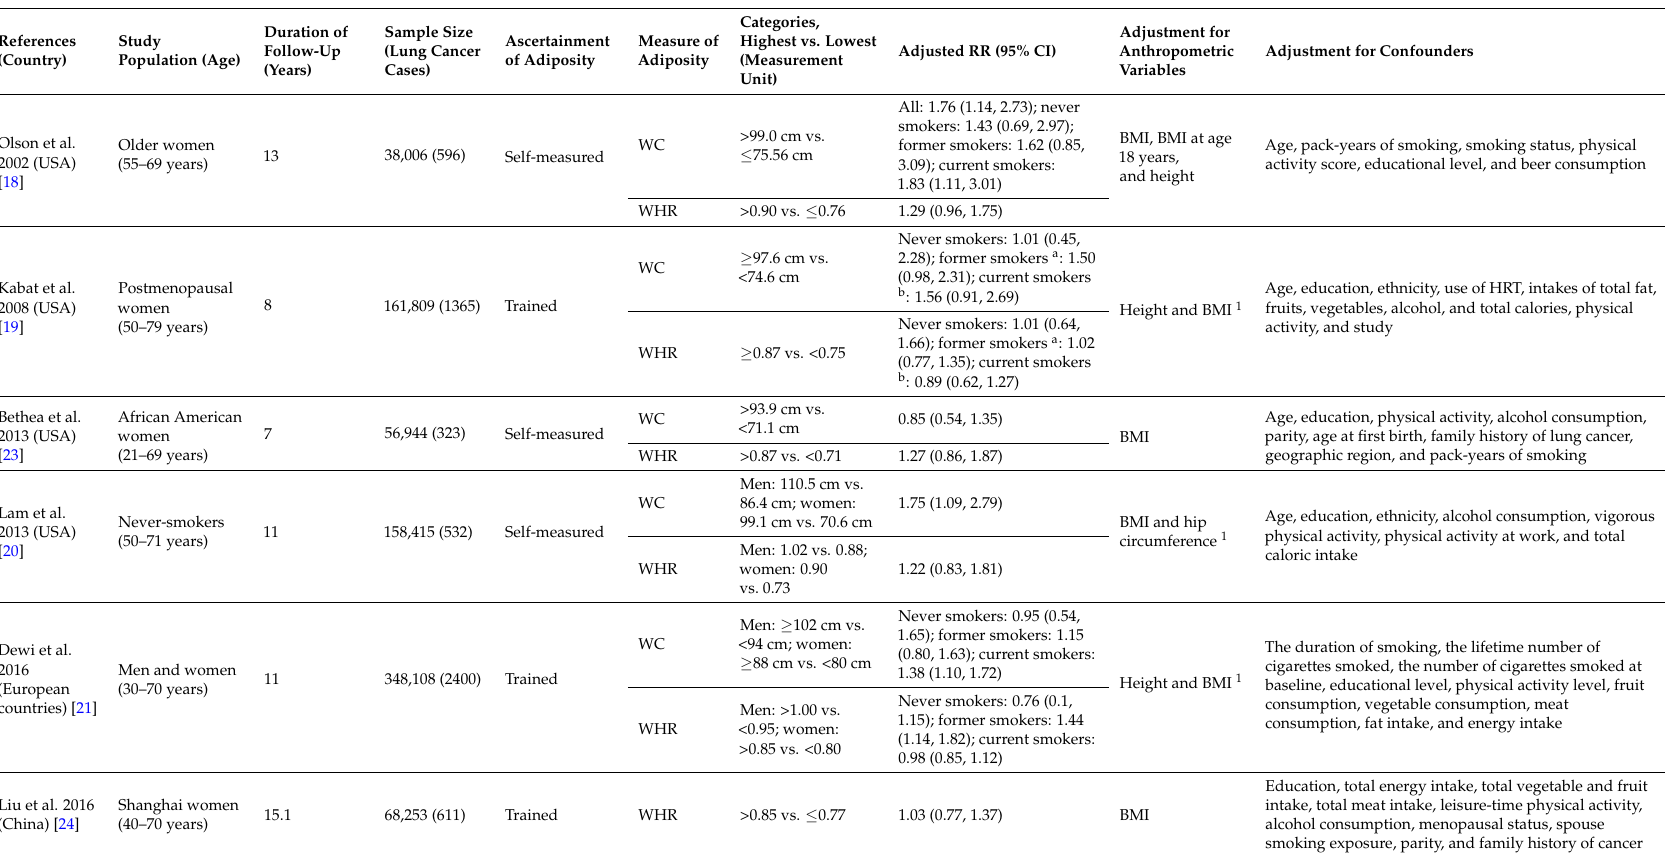
Table 1. Prospective studies of abdominal obesity and lung cancer. All risk estimates for waist circumference were additionally adjusted for body mass index (BMI). All of the risk estimates that are presented below are the ones that we used for the present